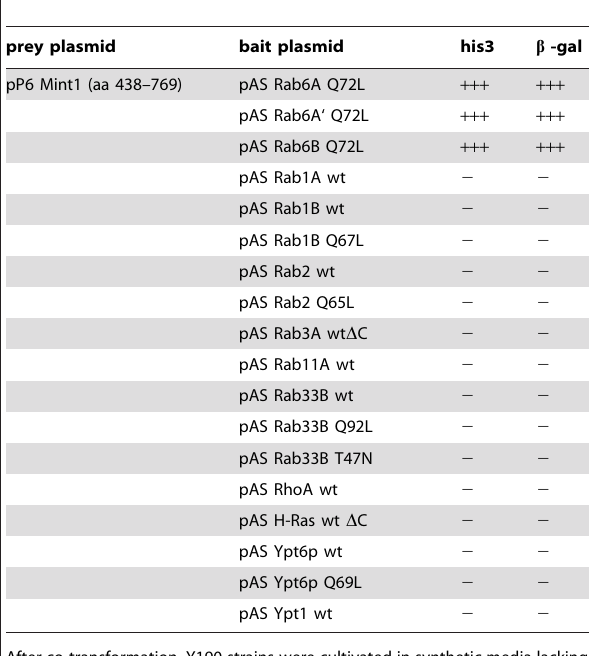
Table 1. Rab specificity of the interaction with